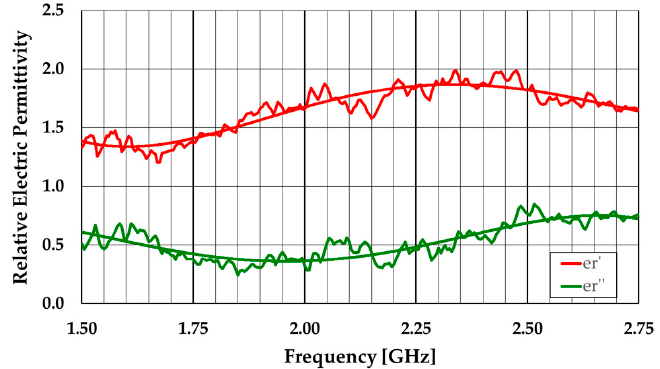
Figure 15. Example of experimental ε r ′ and ε r ″ results.